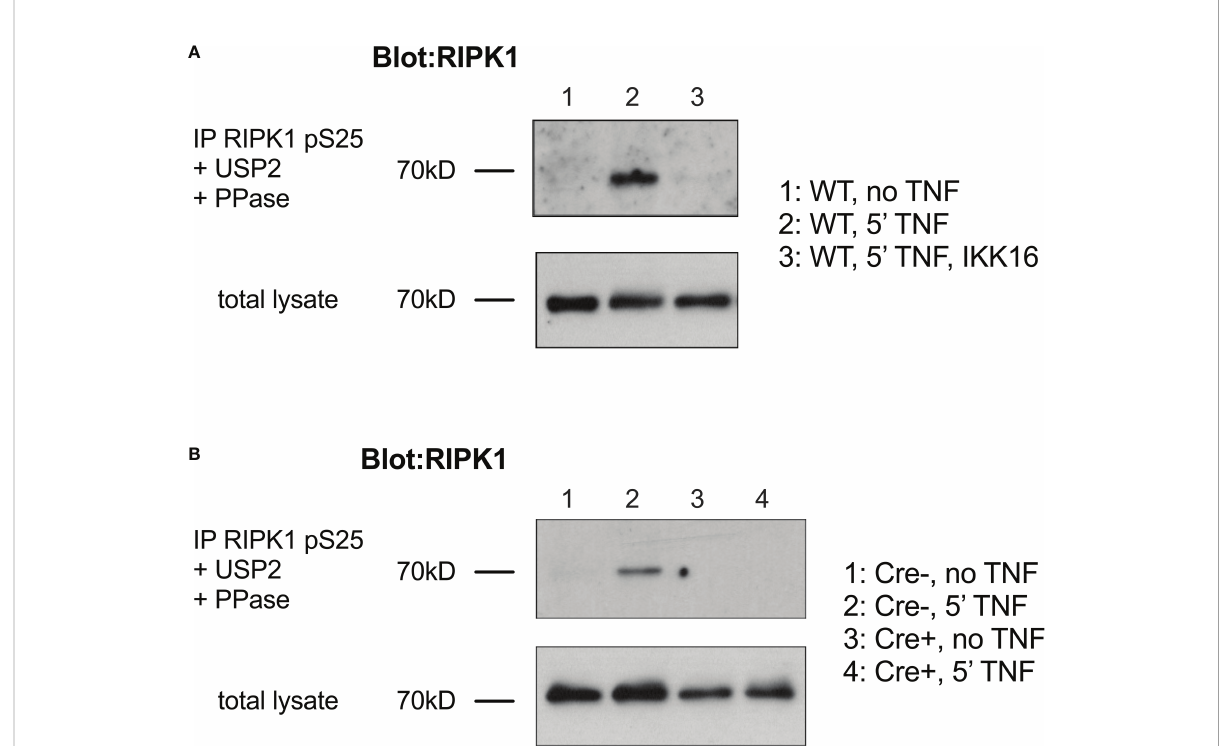
FIGURE 1 Phosphorylation of RIPK1 Ser25 following TNF stimulation is IKK dependent in T cells. (A) Thymocytes from WT mice were stimulated for 5 ’ with PBS (lane 1) or TNF (lane 2-3) (5ng/ml) following pre-incubation for 30 ’ with IKK16 (2µM, lane 3). Cell were lysed and immunoprecipitated with anti-phospho-Ser25 RIPK1 (RIPK1 pS25), followed by treatment with USP2 and PPase. i.p. were separated by gel electrophoresis and RIPK1 protein analysed by western blot. Corresponding total cell lysates were run prior to immunoprecipitation as loading control. (B) Thymocytes from Cre+ and Cre- littermate IKK1/2 D CD2 RIPK1D138N mice were stimulated with TNF and immunopreciptates of anti-RIPK1 pS25 analysed by immunoblotting as described in (A) . Data are representative of one other